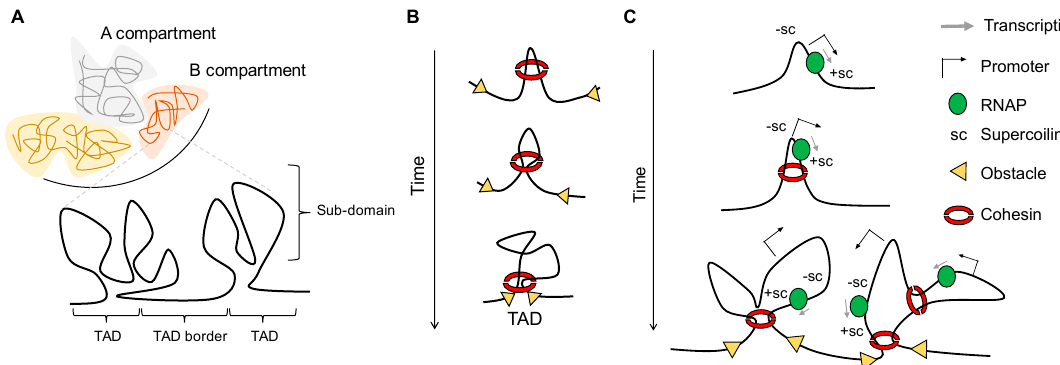
Figure 2. The 3D genome and factors contributing to its organization. ( A ) In the nucleus interphase, chromosomes are organized in A/B compartments, which in turn contain topologically associating domains (TADs) and sub-TADs; ( B ) Models for domain formation by cohesin as a loop extruding factor; ( C ) Transcription-generated supercoiling can contribute to TADs structure. Positive supercoiling generated ahead of the moving RNA polymerase (RNAP) could promote cohesin sliding along the DNA until the complex meets an obstacle such as CTCF or, possibly, another region of supercoiled DNA. Negative supercoiling favours loop formation and stabilization of promoter-enhancer interactions.